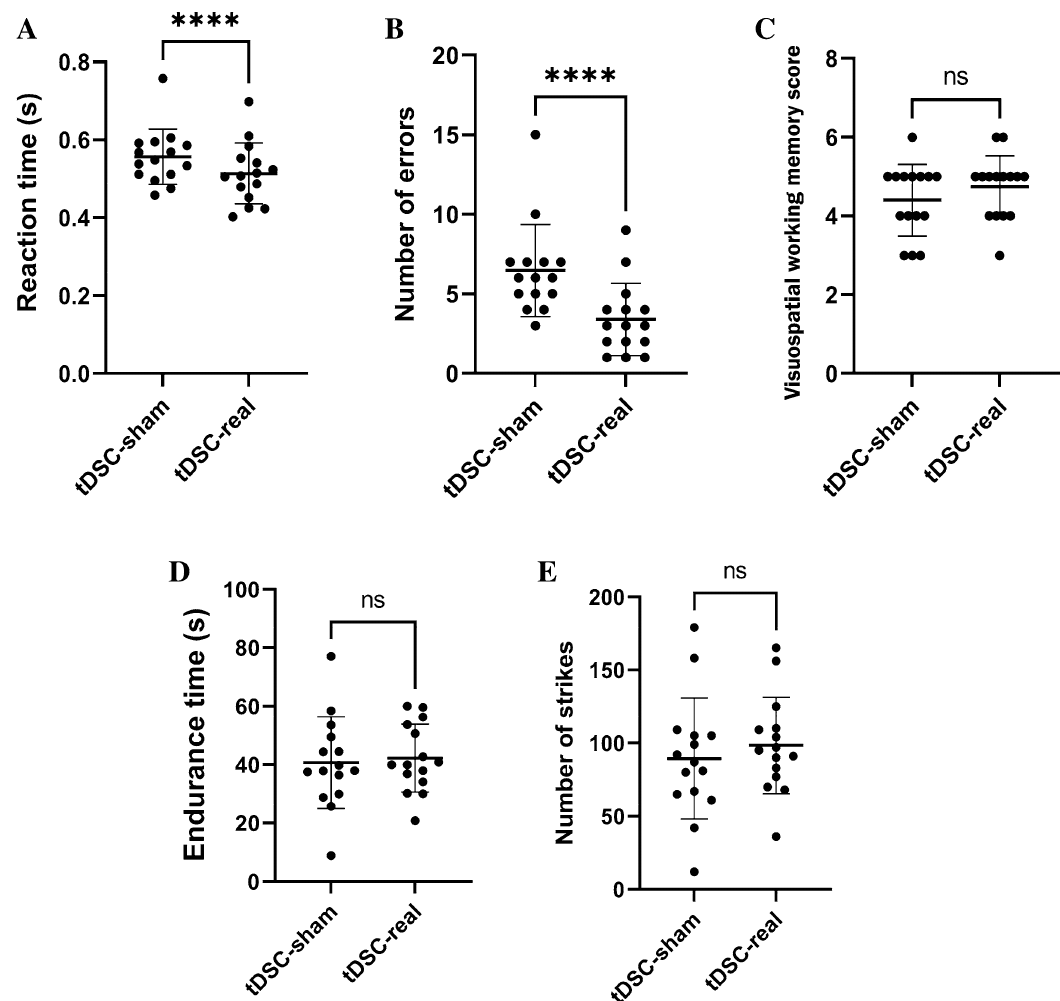
Figure 2. ( A ) Dot plots representing the participants’ performance for the reaction time task. ( B , C ) Dot plots representing the participants’ performance for the selective attention and visuospatial memory tasks. ( D ) Endurance time: Athletes had to successively hit the mannequin, and the test was finished when the athlete put the dominant leg on the ground. ( E ) The number of strokes of the athlete during the endurance task. ****Significant; ( p < 0.0001) ns: